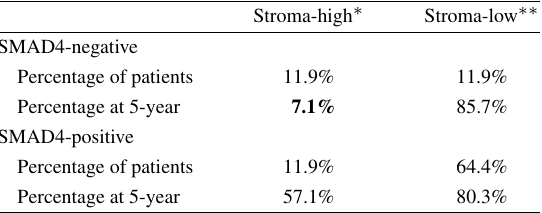
Results of SMAD4 staining relative to the amount of stroma in the primary